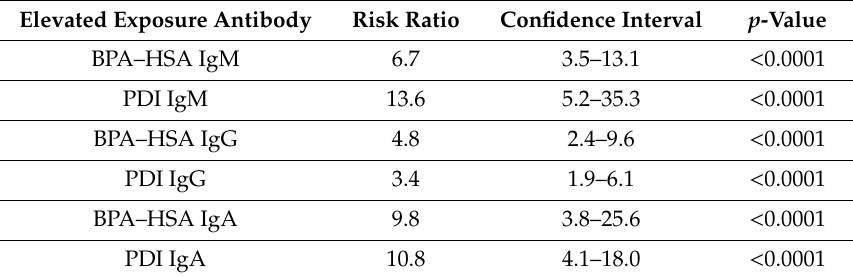
Table 1. Risk ratios for developing elevated alpha-synuclein antibodies .